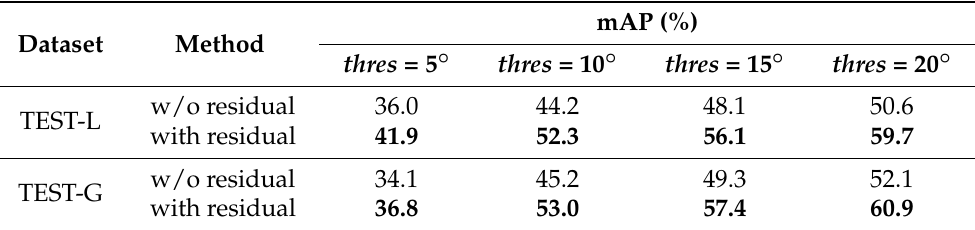
Table 5. Ablation study on rotation prediction (w/o residual: regress the prediction without resid- ual modules).